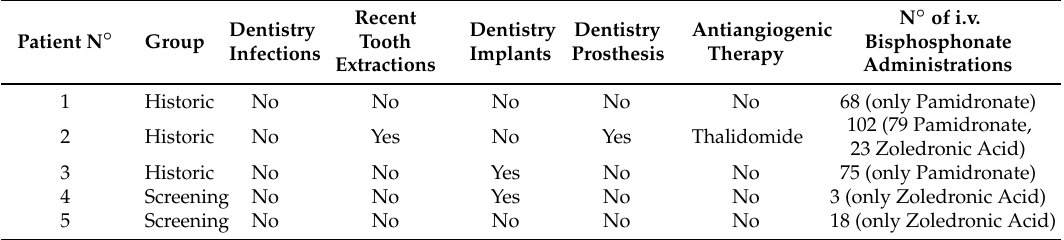
Table 2. ONJ Patient